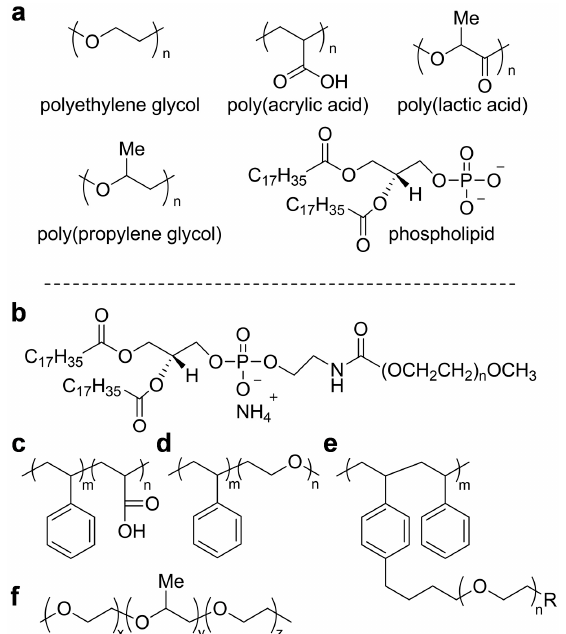
Figure6. ( a )Typicalbasicpolymercomponentsthatcausehydrophilicityinthematerials, and( b – f )select Figure 6. ( a ) Typical basic polymer components that cause hydrophilicity in the materials, and ( b – f ) block copolymers from the basic components which have been notably select block copolymers from the basic components which have been notably used.